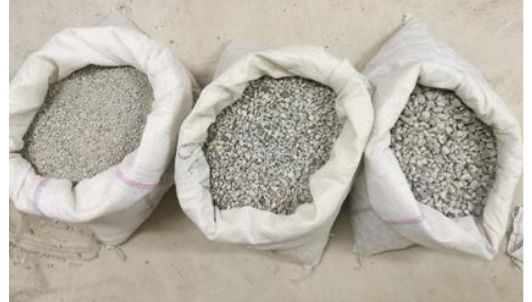
Figure 2. Different sizes of fine and coarse